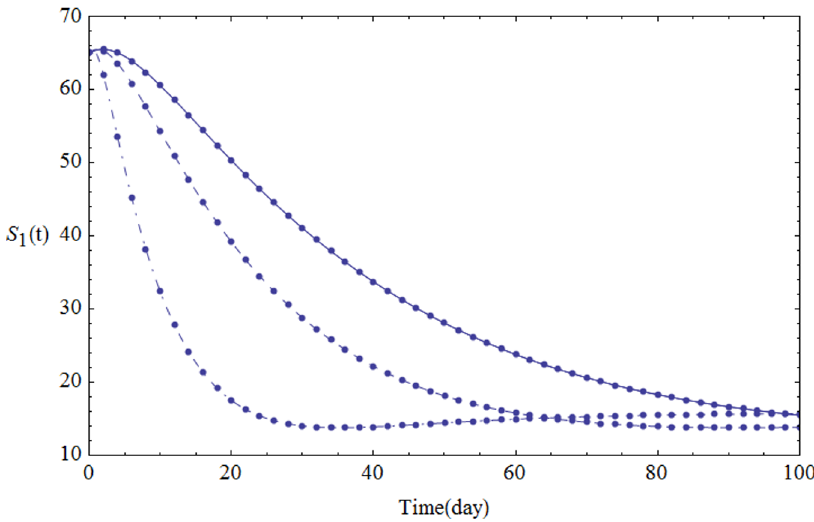
Fig 2. The population of S 1 ( t ) versus t: α = 1.0 (solid line), α = 0.95 (dashed line) and α = 0.85 (dot- dashed line).